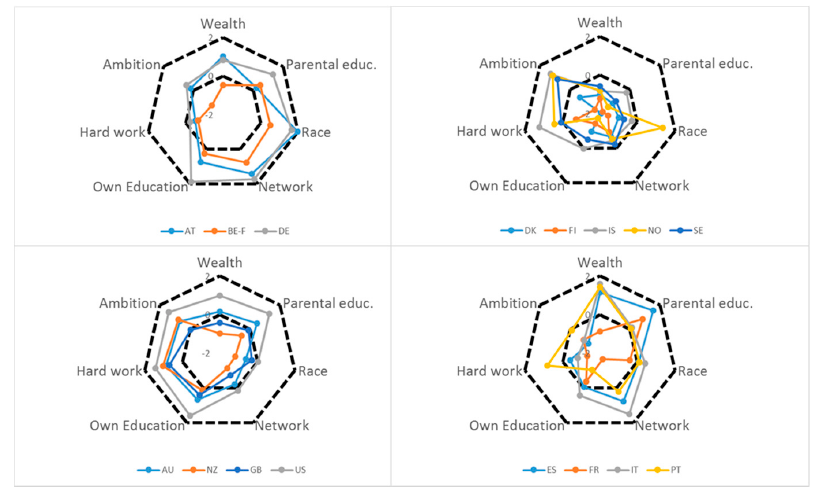
Figure 3. Standardized polygons, representing the shares agreeing that a certain asset is important to get ahead in life.